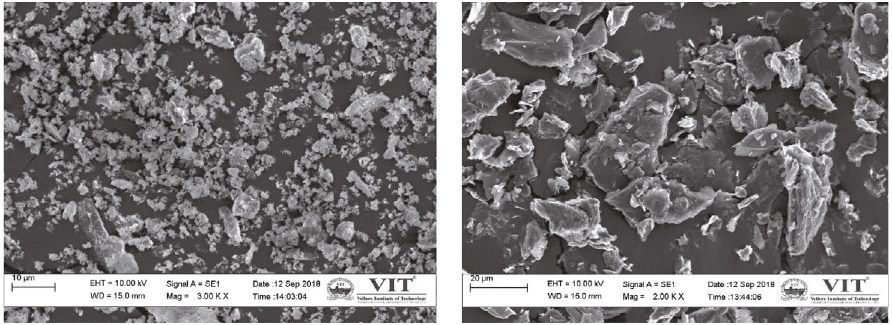
Figure 5: SEM micrograph of the activated